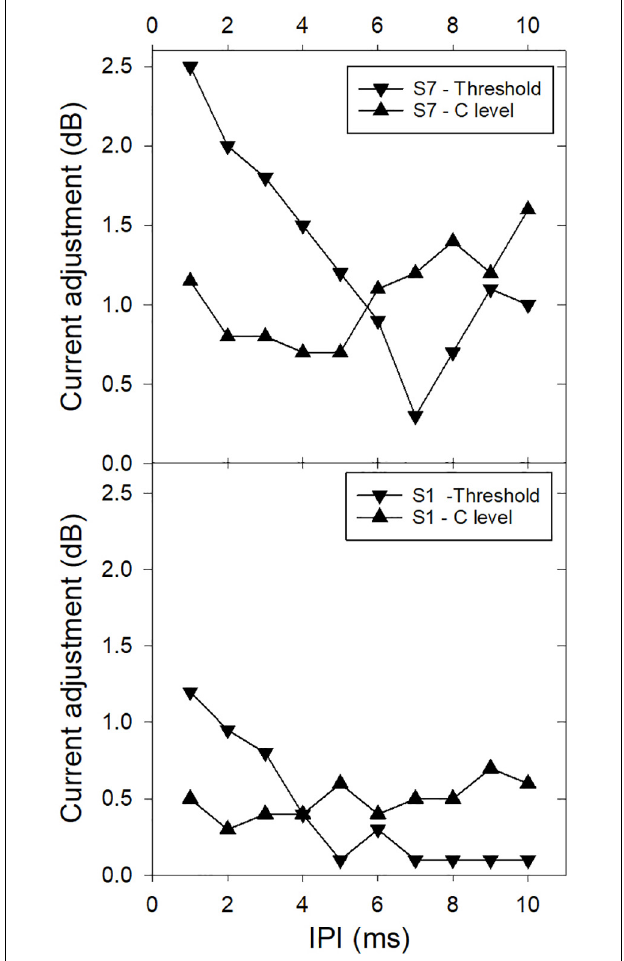
FIGURE 3 | Examples from two CI users showing the effect of interpulse interval (IPI) on loudness summation. The vertical axis shows the current reduction (in dB) needed to make the 2-pulse-per-period stimulus the same loudness (or threshold precept) as the single-pulse-per-period stimulus. The period was 20 ms. The two examples illustrate the non-monotonic effects that are variable between subjects and loudness levels (threshold or comfortable level – C) (Data redrawn from McKay and McDermott,